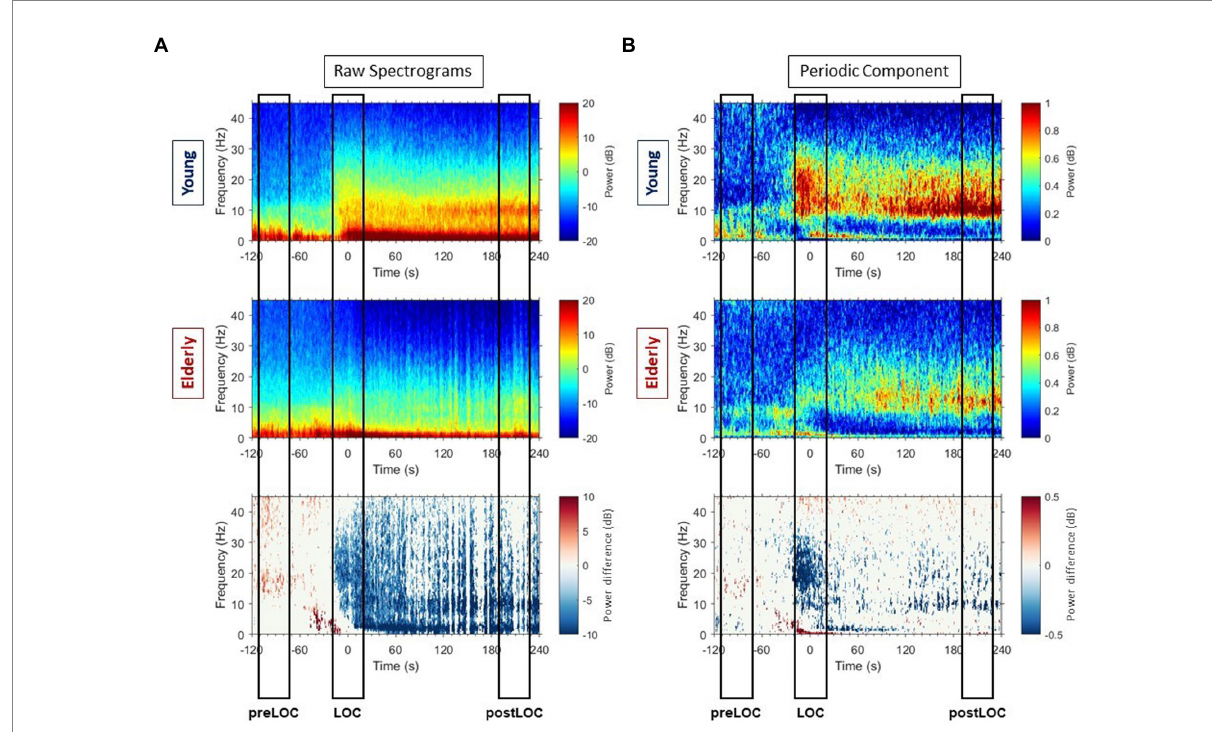
FIGURE 2 Raw spectrograms and spectrograms of periodic components with group differences. (A) Group-averaged raw median spectrograms at Fp1 for the young (upper panel) and elderly (middle panel) cohort with representation of the differences with p ≤ 0.05, calculated with Mann–Whitney- U test at each timepoint and each frequency bin, in blue when the power is higher in the young patients and red when the power is higher in the elderly. (B) Group-averaged median periodic component spectrograms at Fp1 for the young (upper panel) and elderly (middle panel) cohort with representation of the differences with p ≤ 0.05, calculated with Mann–Whitney- U test at each timepoint and each frequency bin, in blue when the power is higher in the young patients and red when the power is higher in the